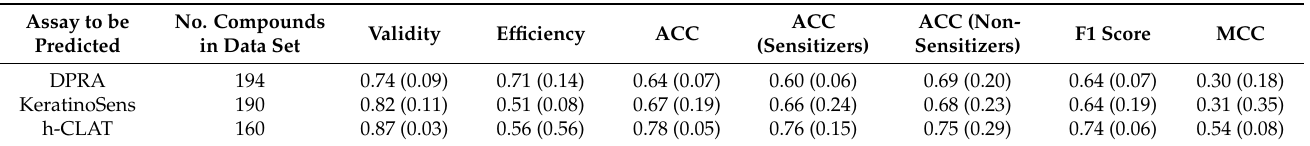
Table 6. Five-fold CV performance of the CP models for DPRA, KeratinoSens assay, and h-CLAT at the significance level of 0.20 1 . Assay to be